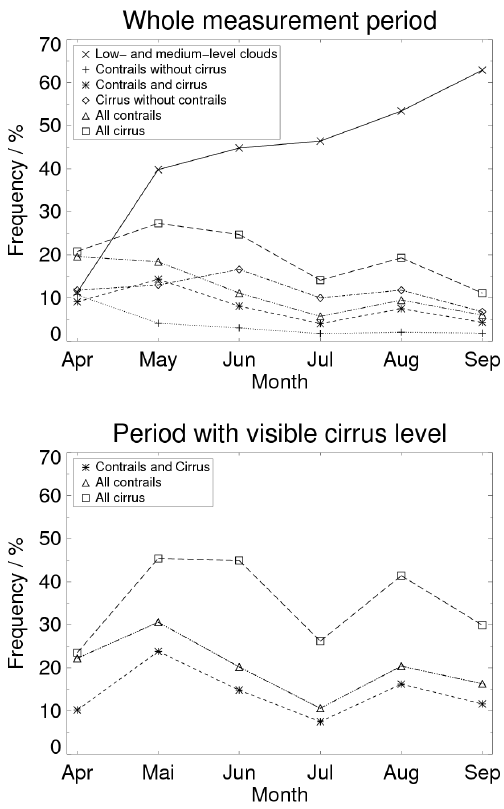
Fig. 3. Monthly mean values from the visual classification of ground based images. Top: Frequency of the occurrence of the cat- egories “Low- and medium-level clouds” ( × ), “Contrails without cirrus” ( + ), “Contrails and cirrus” ( ∗ ), “Cirrus without contrails” ( ♦ ), “All contrails” ( 4 ), and “All cirrus” ( (cid:3) ) w.r.t. the full measure- ment period. Bottom: Frequency of occurrence of the categories “Contrails and cirrus” ( ∗ ), “All contrails” ( 4 ) and “All cirrus” ( (cid:3) ) when the cirrus level was visible.